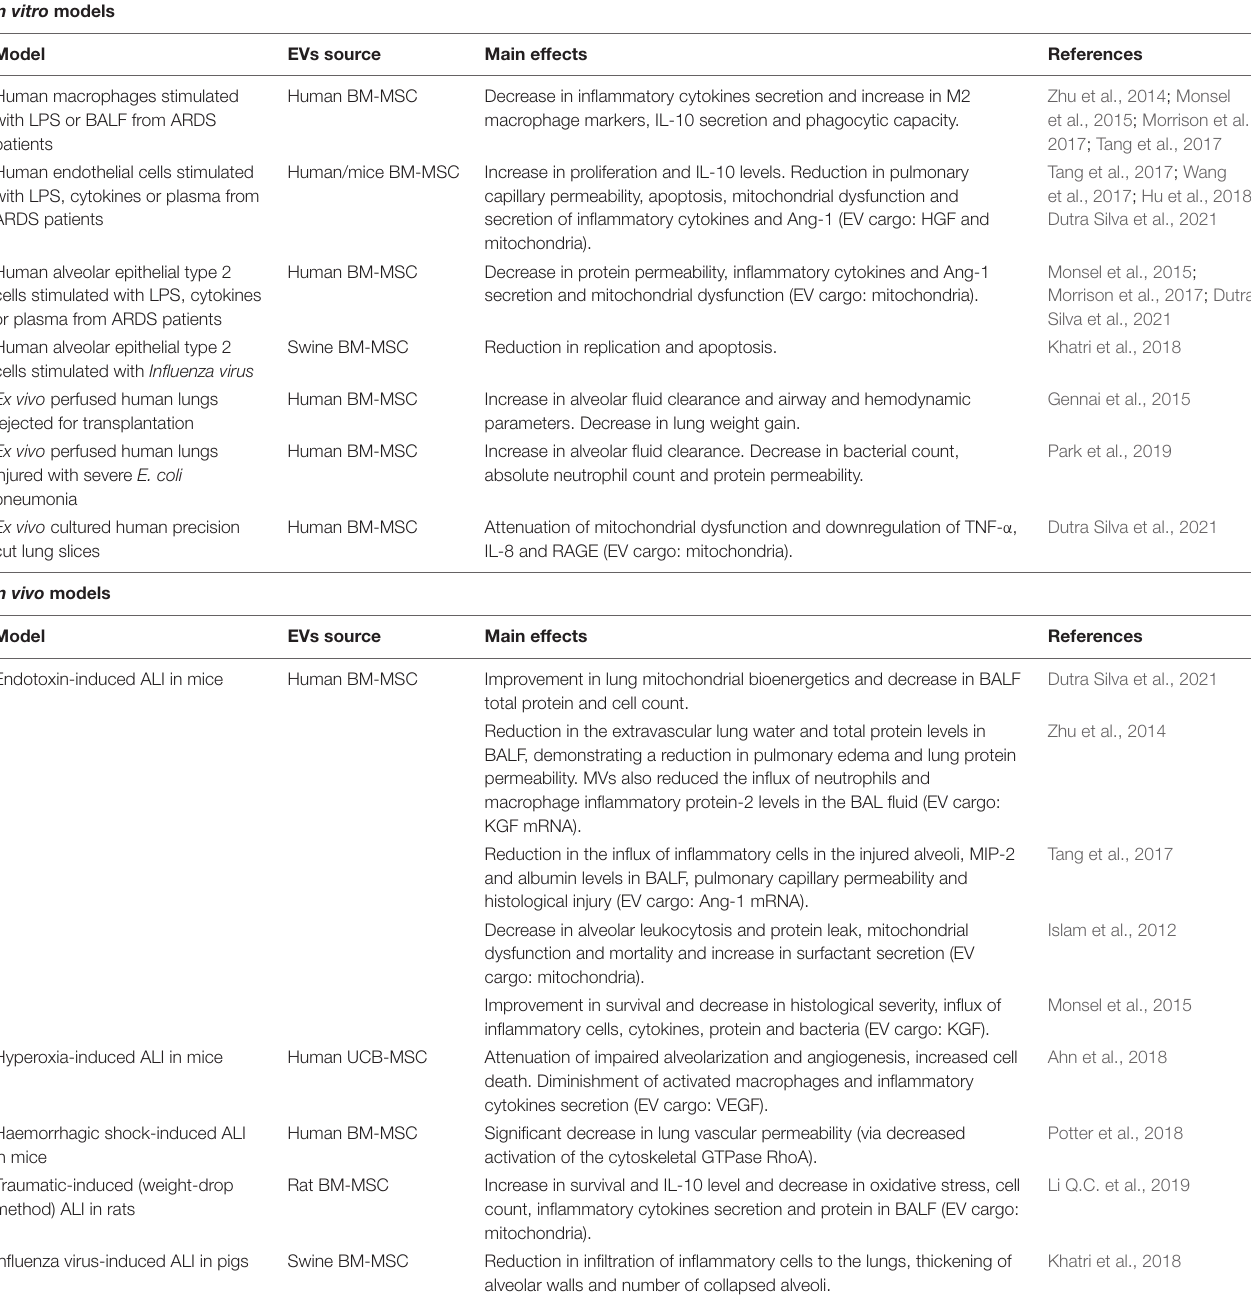
TABLE 3 | Therapeutic potential of EVs derived from mesenchymal stem cells in